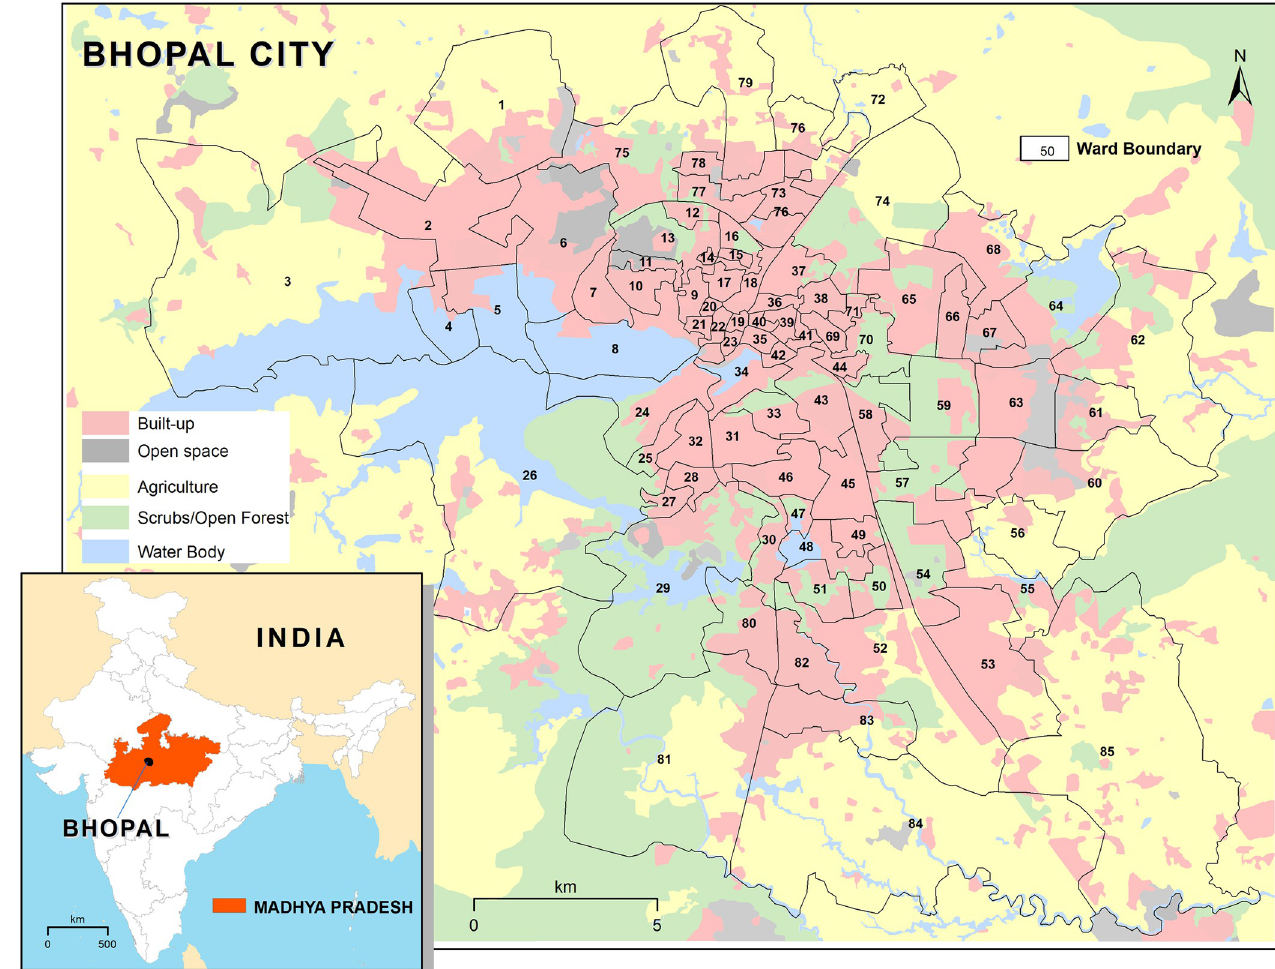
Fig 1. Location map and administrative boundaries of Bhopal city, Madhya Pradesh, India (Source of shapefile: http://projects.datameet.org/Municipal_ Spatial_Data/).